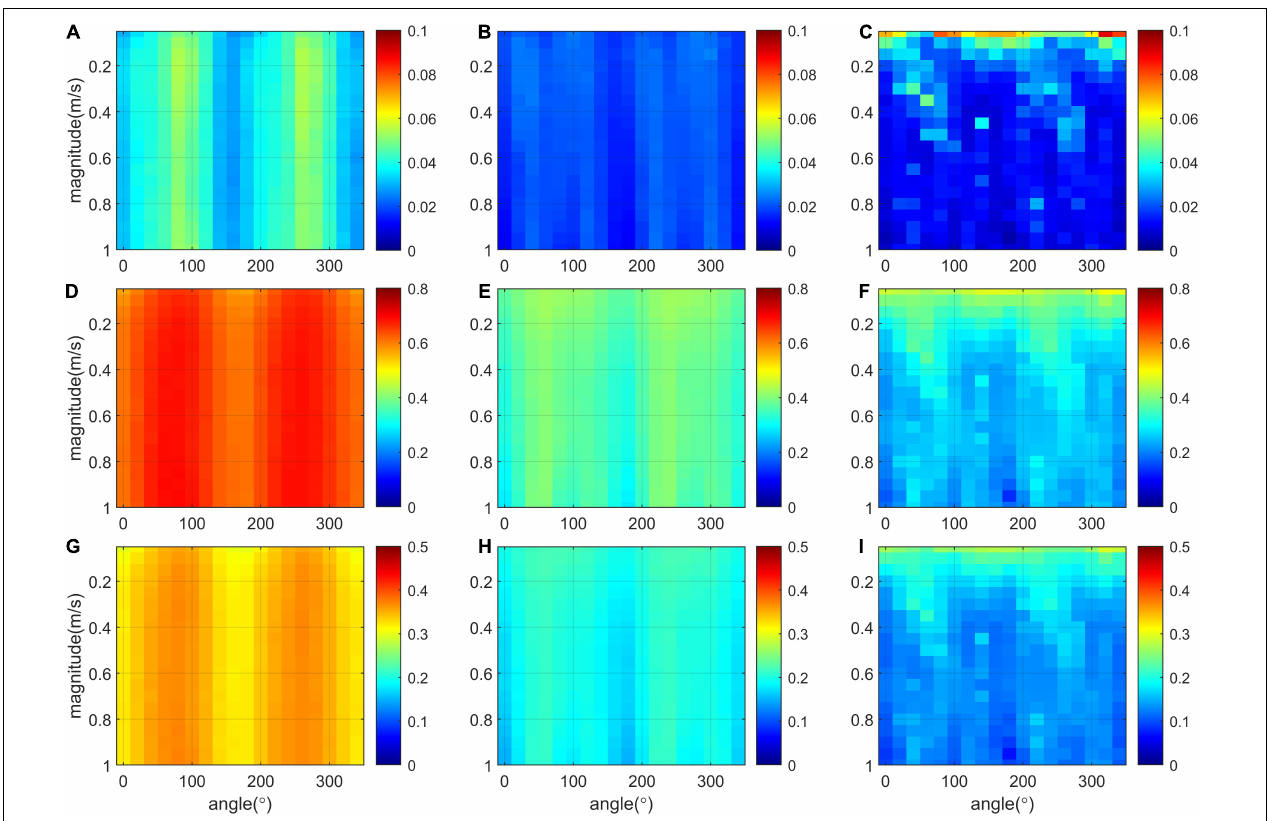
FIGURE 2 | Spatially-averaged WRI (upper panels), WMI (middle panels), CMRI (lower panels) errors for SST-R (A,D,G) , SST-G (B,E,H) , and SST-G 2 (C,F,I) depending on the magnitude and direction of V true . SST-R, SST-G, and SST-G 2 indicate surface current generated from the raw SST, the spatial gradient of raw SST, and the second order spatial gradient of raw SST, respectively.